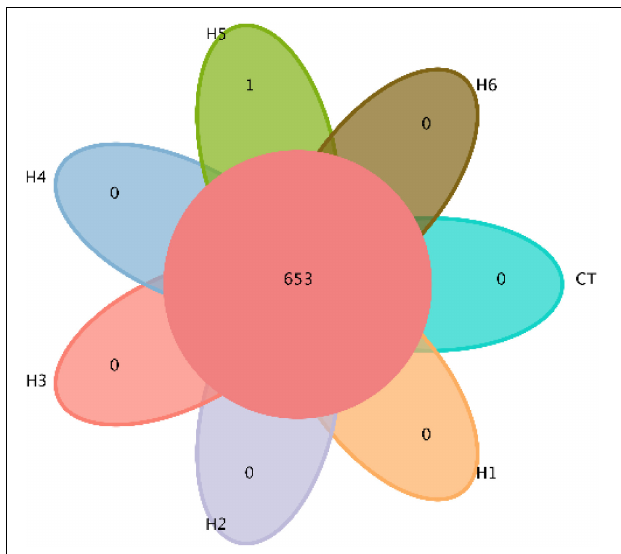
FIGURE 4 | Venn diagram demonstrating the distribution of operational taxonomic units (OTUs) shared by juvenile pearl gentian hybrid grouper fed with different levels of